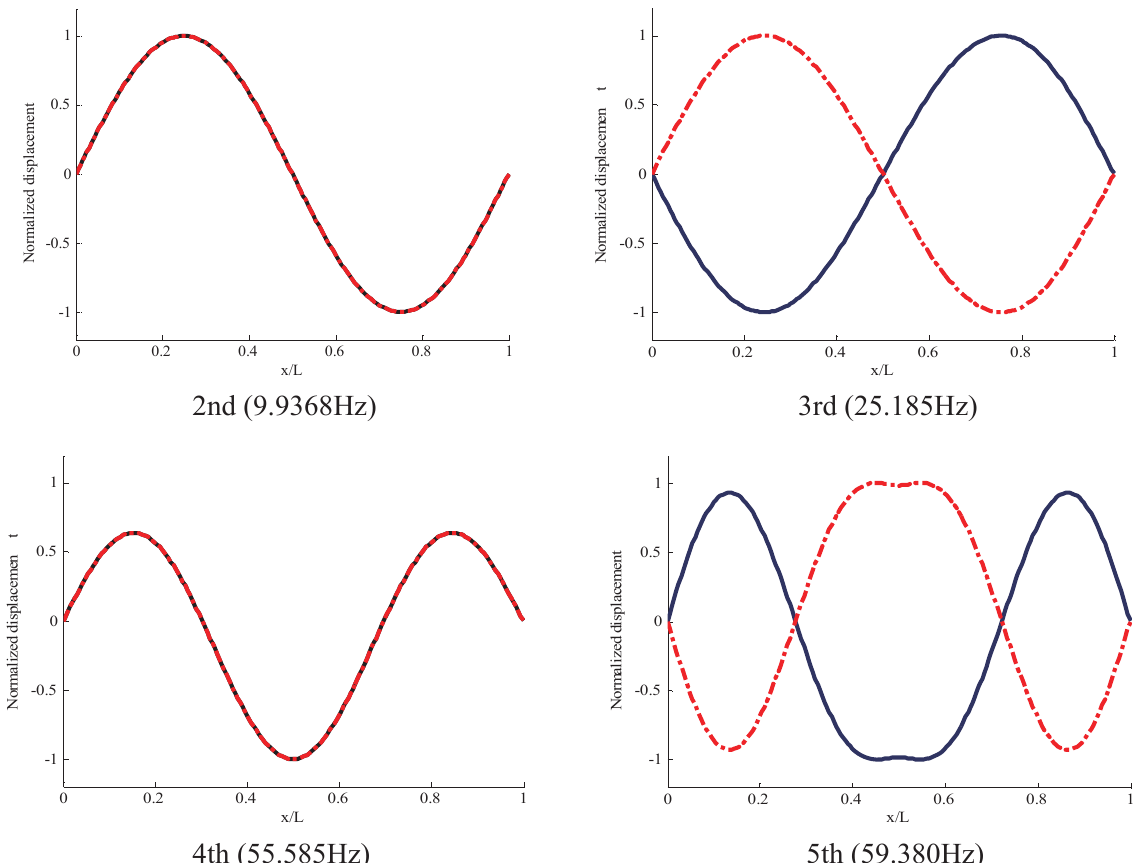
Solid line: displacement of Beam-I; Dash-dot line: displacement of Beam-II Fig. 7. Selected mode shapes of the beams